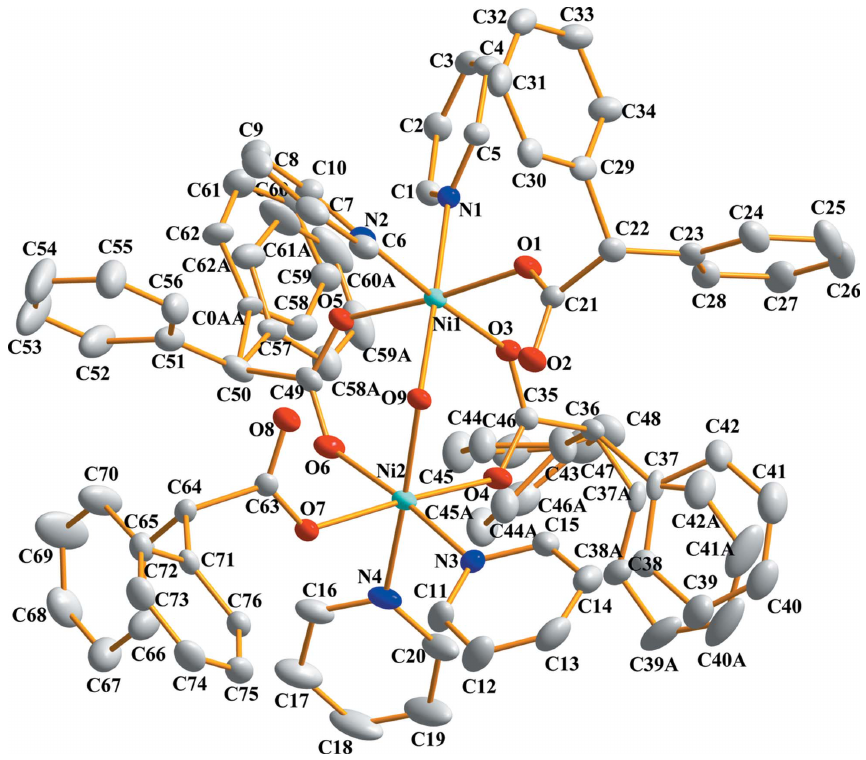
Figure 1 The molecular structure of 1 , showing the atom-labelling scheme. Displacement ellipsoids are drawn at the 50% probability level. H atoms have been omitted for clarity.